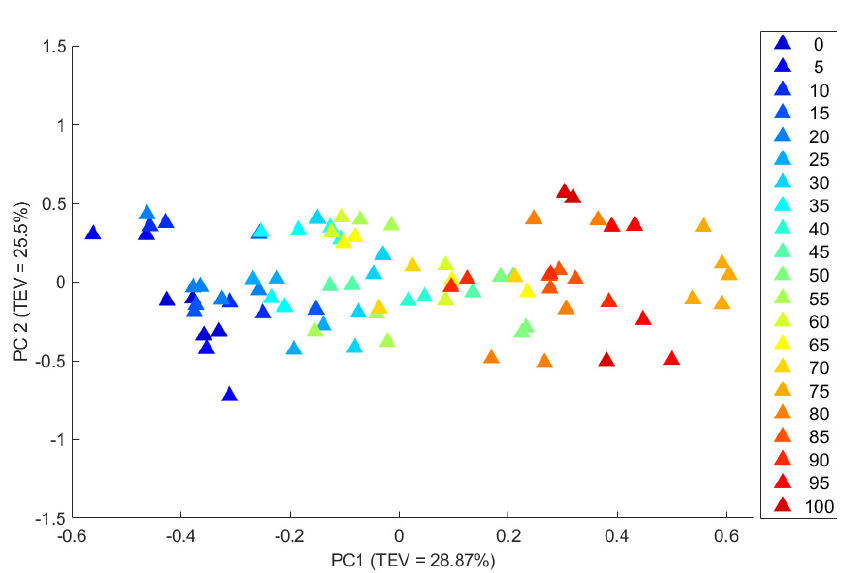
Figure 3. PCA scores plots of Raman spectral data collected using a handheld instrument with 1064 nm excitation showing the adulteration of authentic EVOO with pomace olive oil. The adulteration has been performed in increments of 5% and a rainbow colour gradient from blue for pure EVOO to red for pure pomace OO is shown. The values in parentheses on the axes labels are the percentage of the total explained variance (TEV) for each principal component (PC).